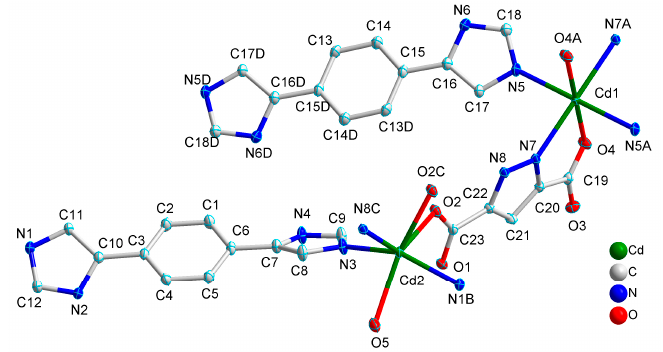
Figure 1. The coordination environment of Cd(II) ion in 1 with the ellipsoids drawn at the 30% probability level. The hydrogen atoms are omitted for clarity. Symmetry code: A 1 − x, − y, 3 − z, B − 1 + x, y, 1 + z, C 1 − x, 1 − y, 2 − z, D 2 − x, − y, 2 −